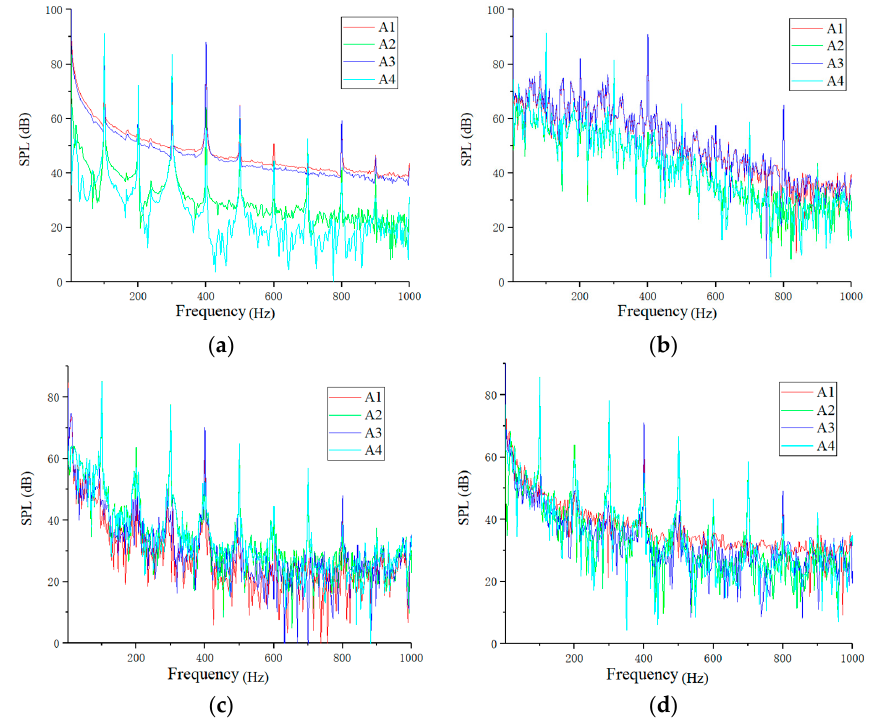
Figure 13. The spectrum diagram of SPL of class A monitoring points at different navigational speed. ( a ) 0 m/s; ( b ) 0.37 m/s; ( c ) 1.54 m/s; ( d ) 2.057 m/s.